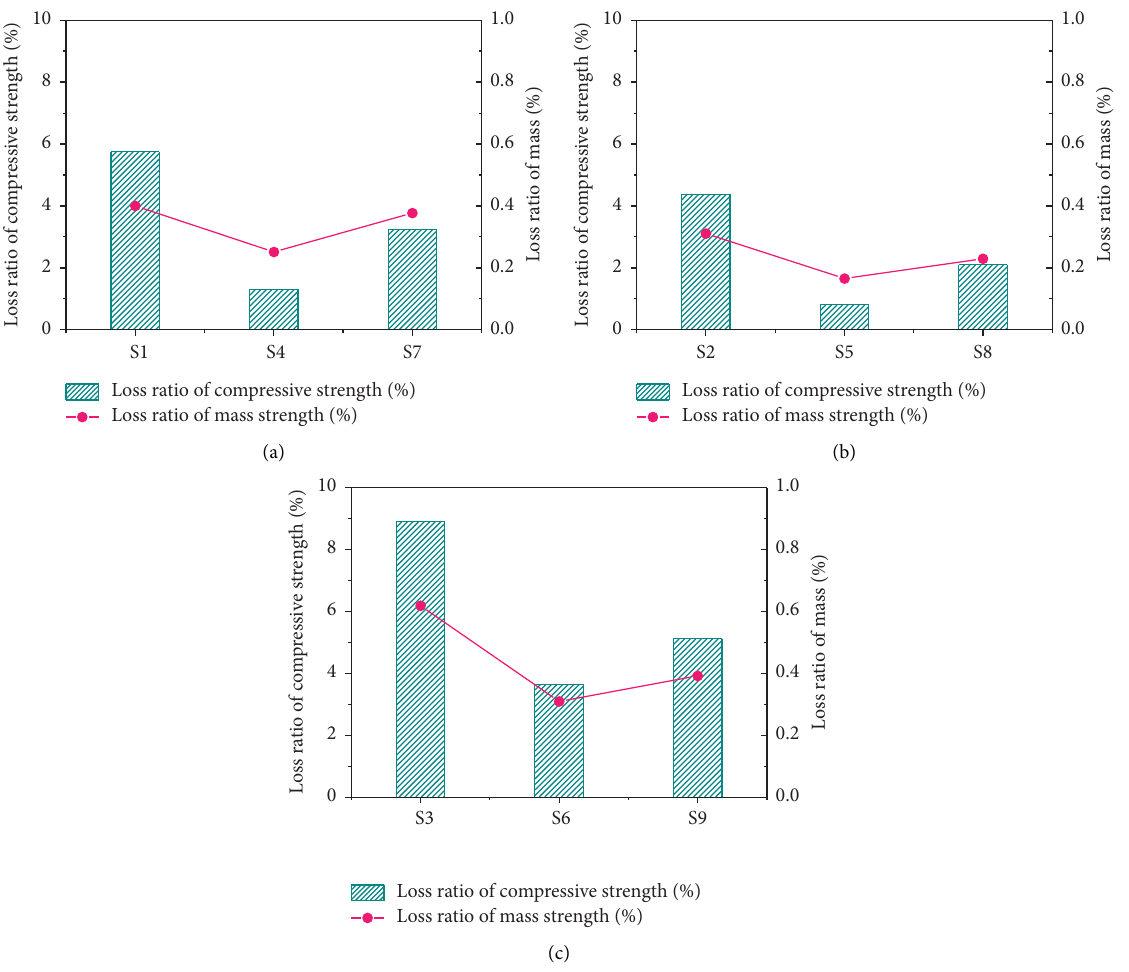
Figure 8: Compressive strength and mass loss rate of HPC different amounts of mineral admixtures. (a) 10%, (b) 20%, (c) 30%.